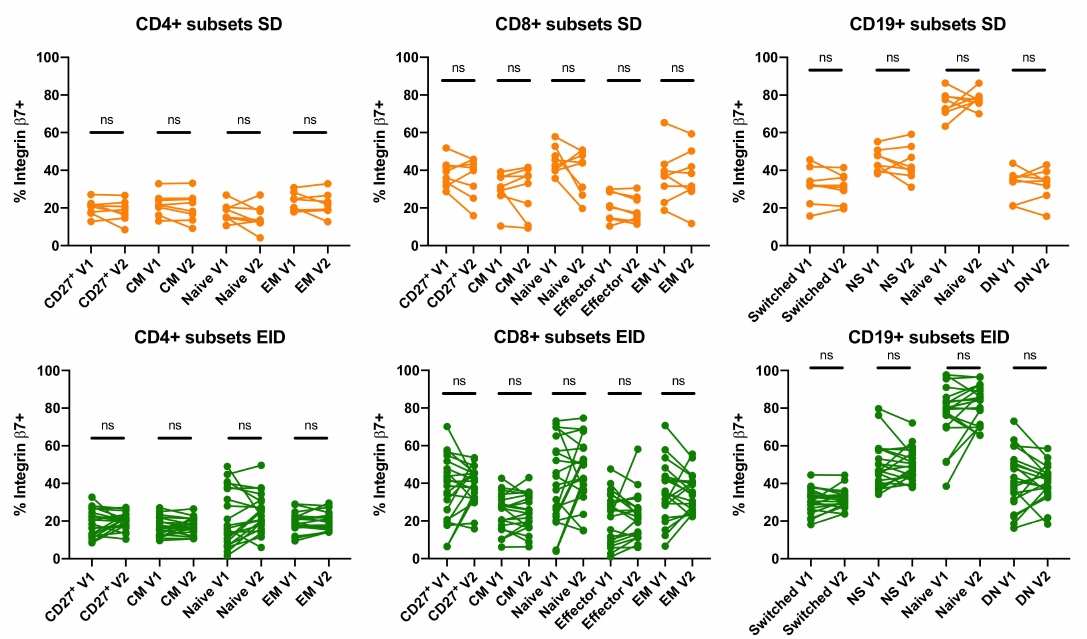
Figure A6. Comparison of first (V1) and second (V2) extractions within CD4 + and CD8 + T lymphocytes, and CD19 + B lymphocytes subpopulations in RRMS patients under Natalizumab treatment in SD or EID. Percentage of expression of β 7-Integrin in all CD4 + and CD8 + T lymphocytes, and CD19 + B lymphocytes subsets. Each dot represents the percentage of expression of β 7-Integrin regarding their parent population (CD4 + or CD8 + T lymphocytes, or CD19 + B lymphocytes populations) in the SD ( n = 8) and EID ( n = 21) groups. CM, Central Memory; DN, Double Negative; EID, extended interval dosing; EM, Effector Memory; NS, Non-Switched; SD, standard dosing. ns: p >